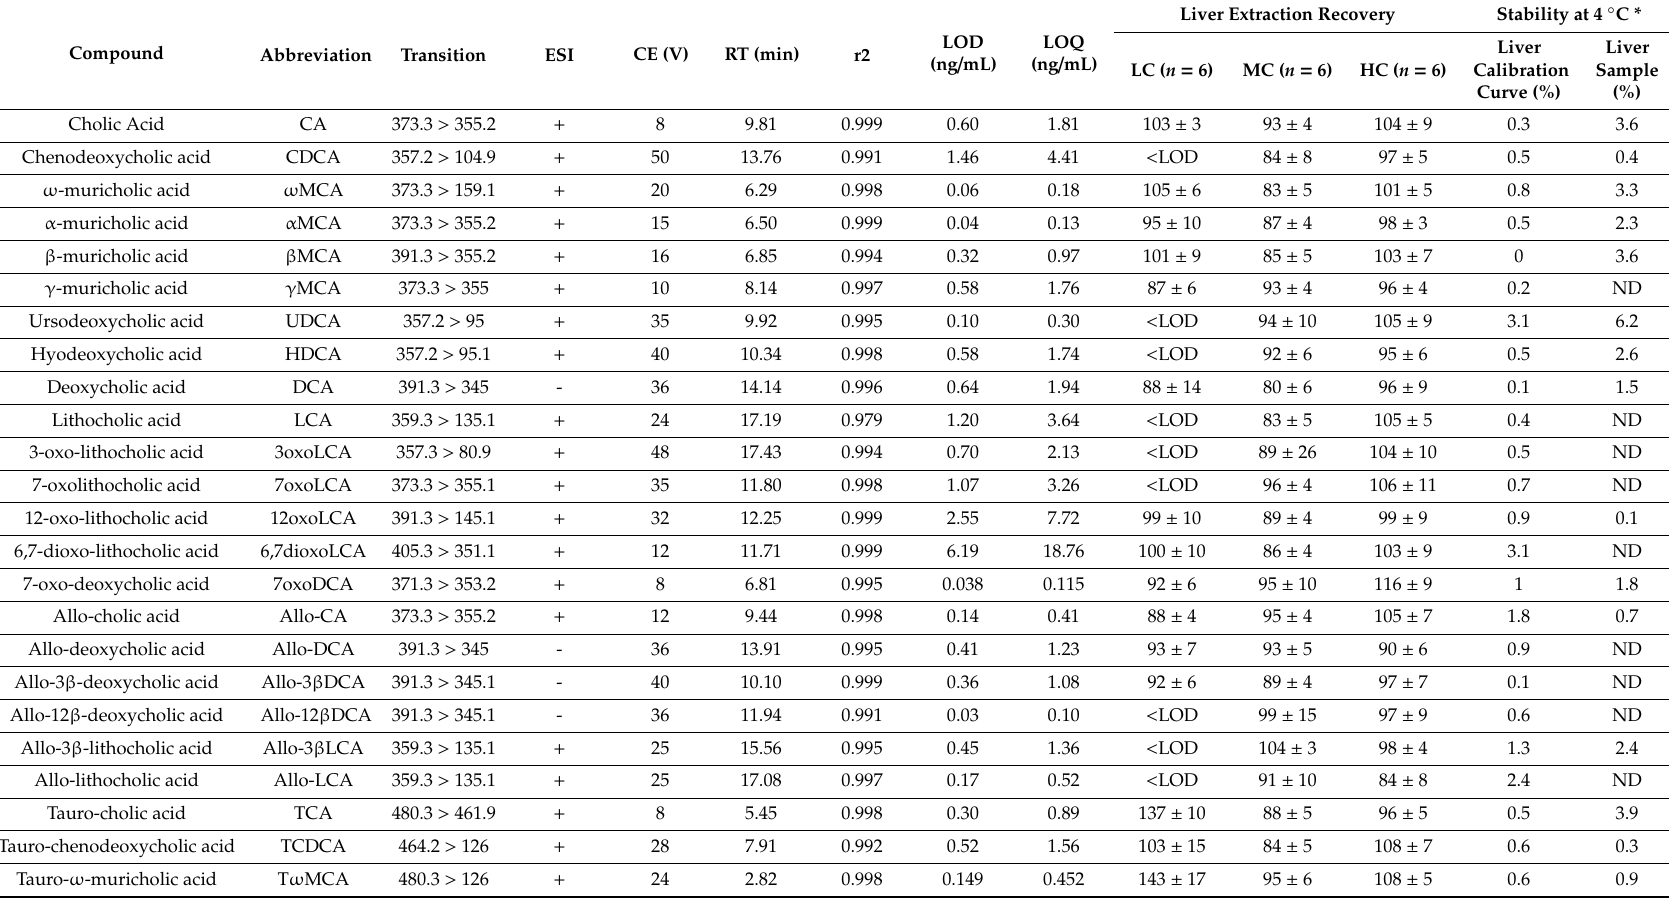
Table 2. Method characteristics and validation parameters for the quantification bile acids in liver tissue by LC-MS / MS. Abbreviations: CE: collision energy; RT: retention time; R2: linearity; LOD: limit of detection; LOQ: limit of quantitation; LC: low concentration; MC: medium concentration; HC: high concentration, ND: not